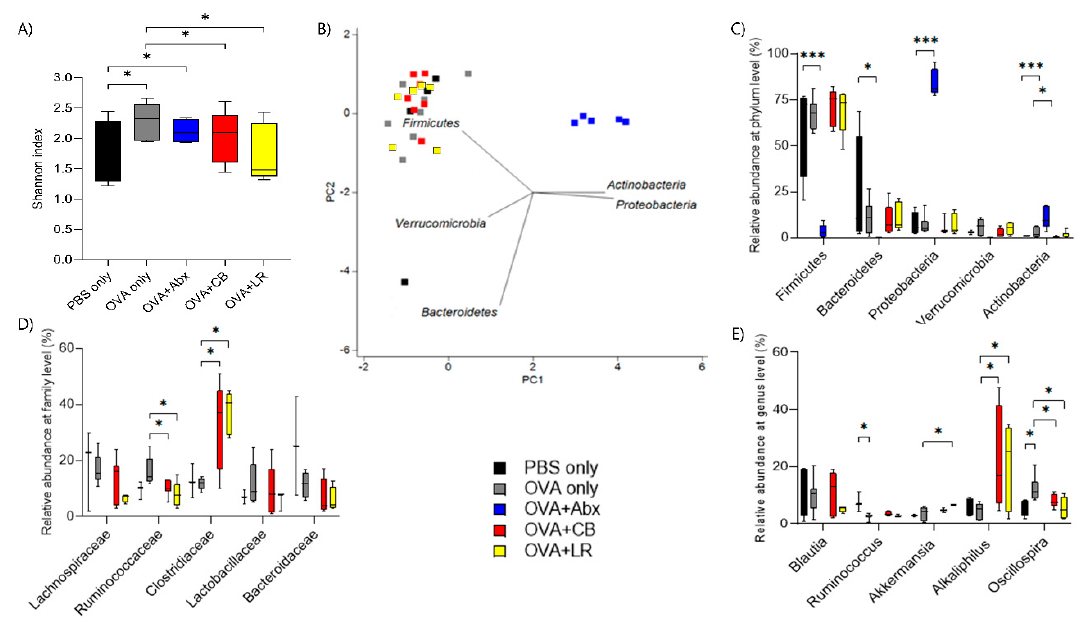
Figure 8. (A) Diversity profiles of the gut microbiota. (B) Principal component analysis at the phylum-level in fecal contents. (C) Phylum-level taxonomic distributions of the microbial communities. (D) Composition of the gut microbiota at the family level. Lachnospiraceae, Ruminococcaceae, Clostridiaceae, and Bacteroidaceae were not detected in the antibiotics treated groups. (E) Composition of the gut microbiota at the genus level. Blautia , Ruminococcus , Akkermansia , Alkaliphilus , and Oscillospira were not detected in the antibiotics treated groups. Boxes represent the 25th to 75th percentiles; middle bar identifies the median; whiskers show the minimum and maximum ( n = 5–7 rats per group). * p < 0.05, ** p < 0.01, *** p < 0.001 determined by permutational multivariate analysis of variance (PERMANOVA). ns, no significance; Abx, antibiotics; CB, C. butyricum ; LR, L. reuteri .